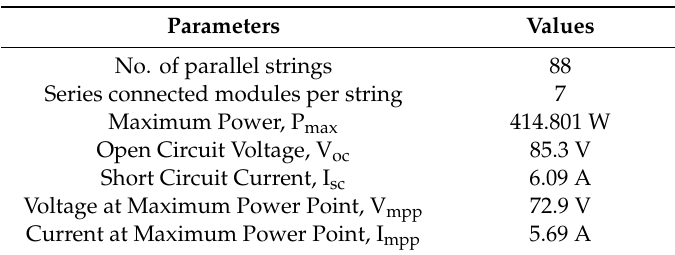
Table 1. Specifications of solar panel.